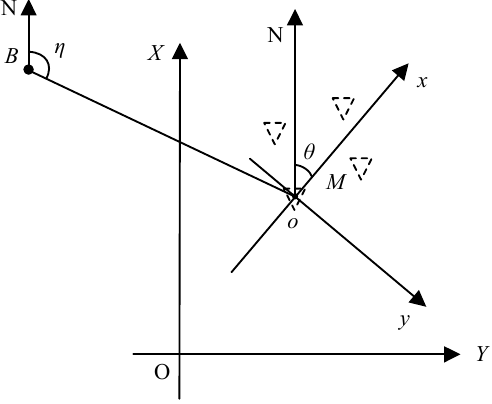
Figure 2. Global and local coordinate systems for positioning.